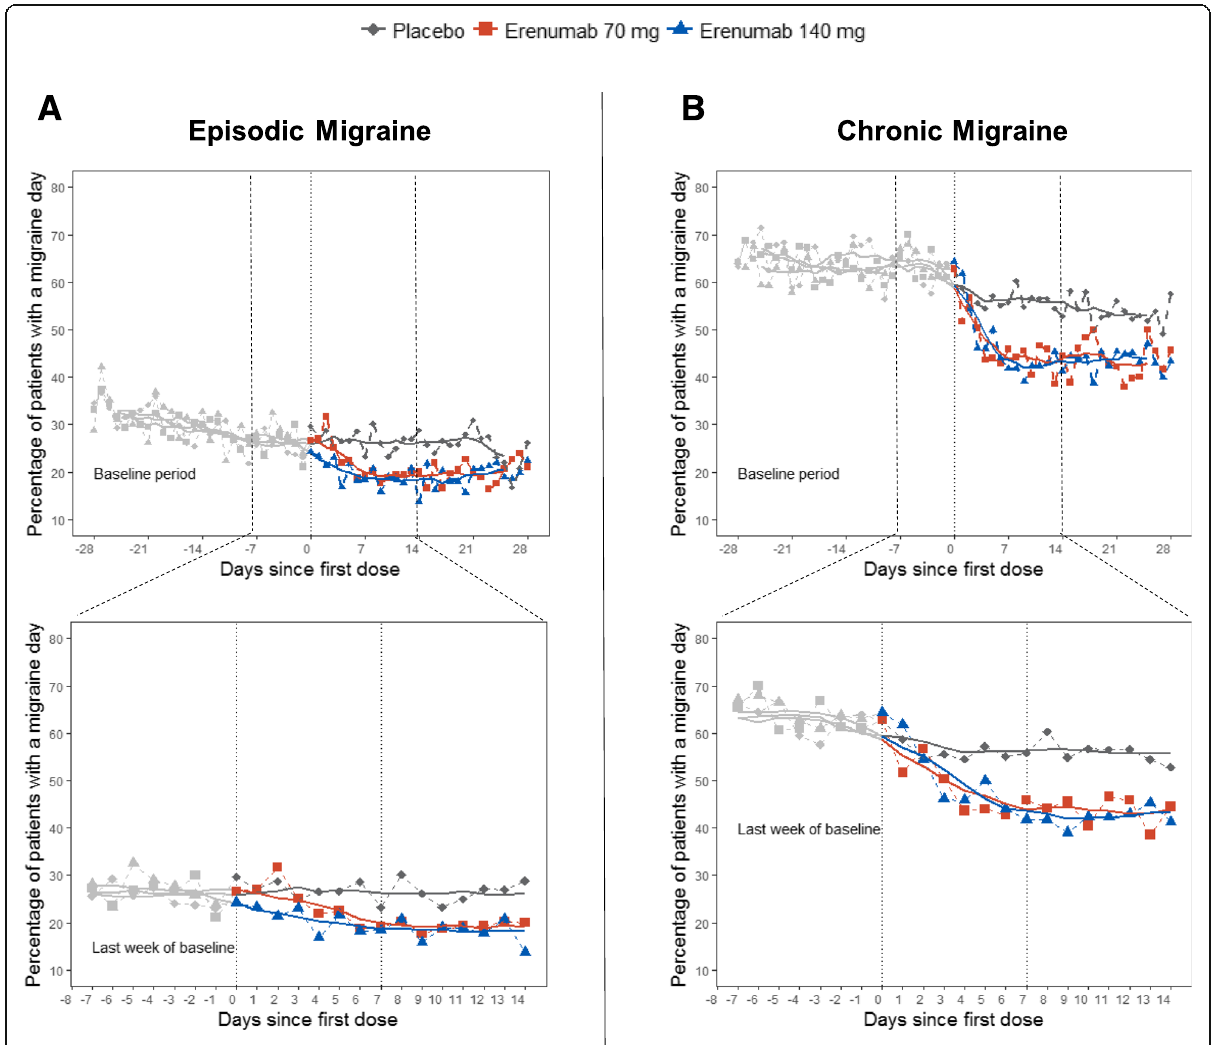
Fig. 4 Percentage of patients with episodic migraine ( a ) chronic migraine ( b ) with a migraine day and 7-day moving averages for the 4-week baseline period and first 4-weeks of double-blind treatment (top panel) and for the last week of baseline and first 2 weeks of double-blind treatment (bottom